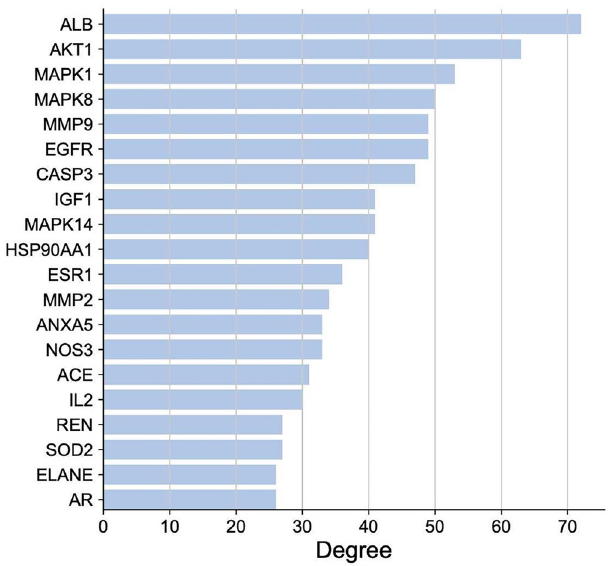
Figure 3. Top 20 targets from the PPI network.